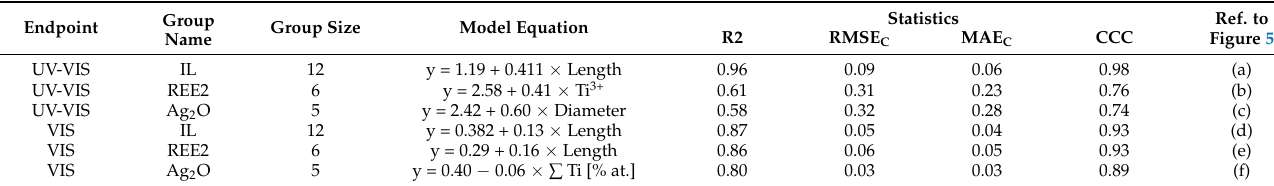
Table 1. Summary of Linear models for 23 TiO 2 -based NTs.